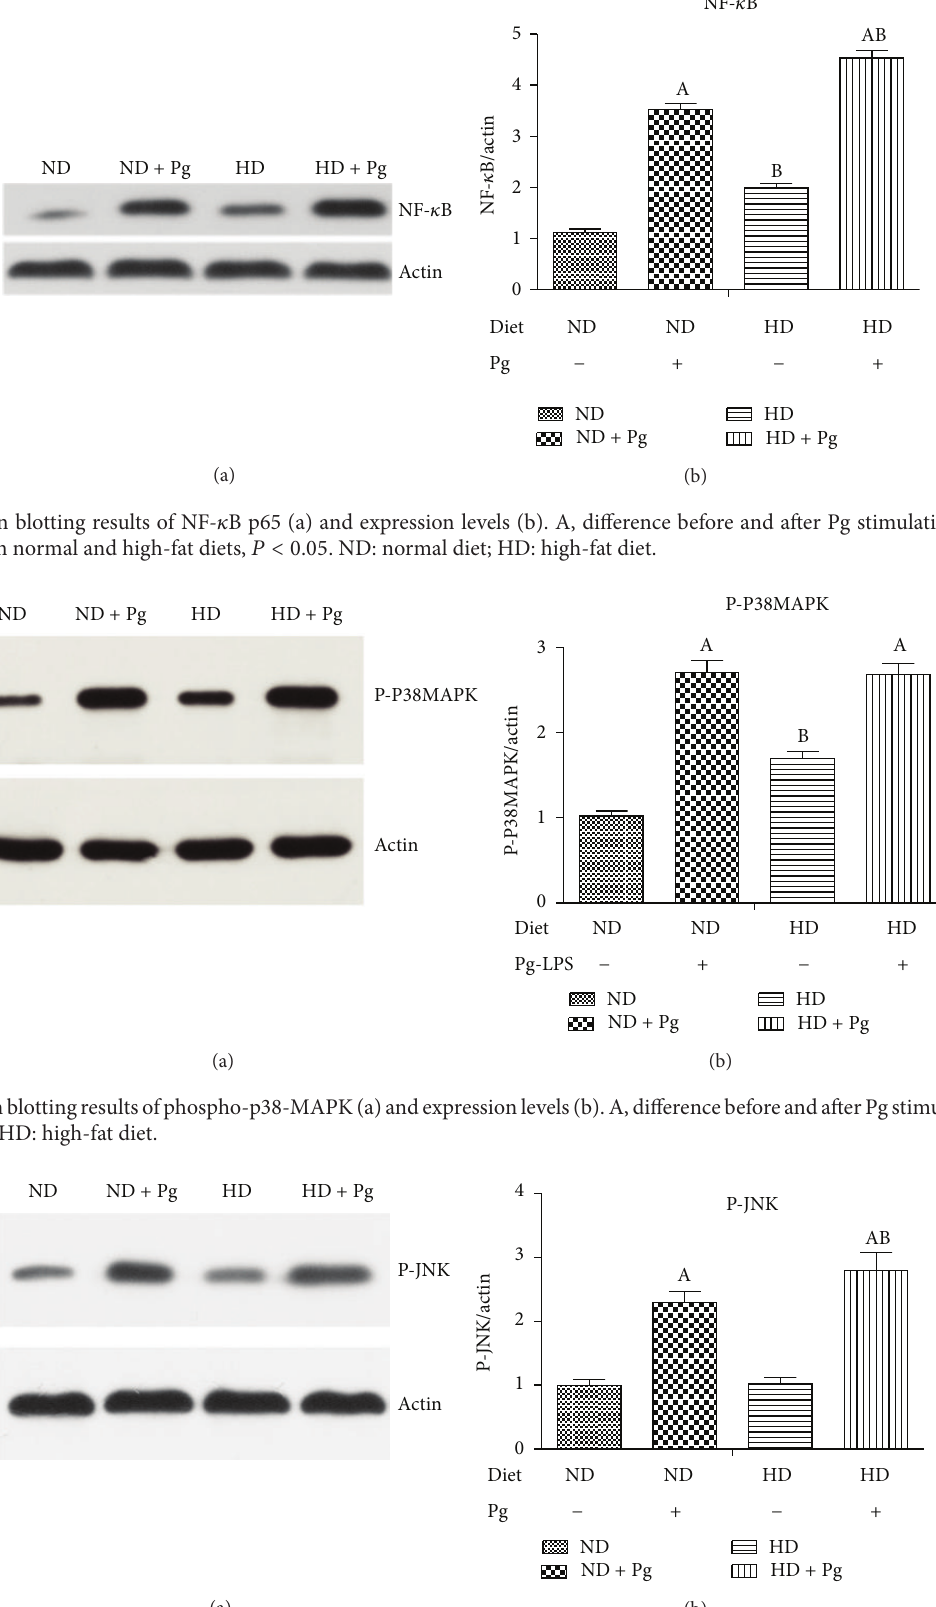
Figure 7: Western blotting results of phospho-JNK (a) and expression levels (b). A, difference before and after Pg stimulation, 𝑃 < 0.05 ; B, difference between normal and high-fat diets, 𝑃 < 0.05 . ND: normal diet; HD: high-fat